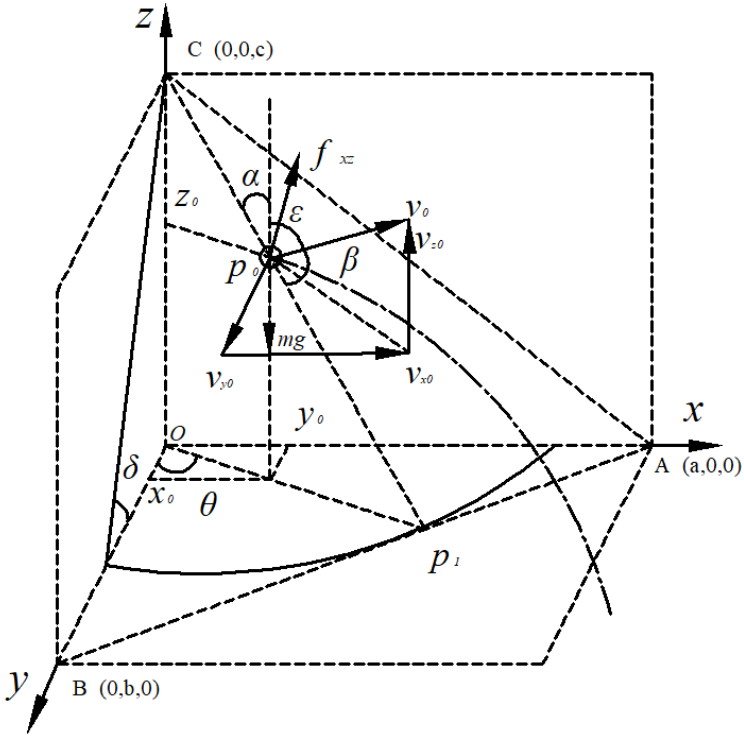
Figure 7. Schematic diagram of fertilizer particle motion analysis.